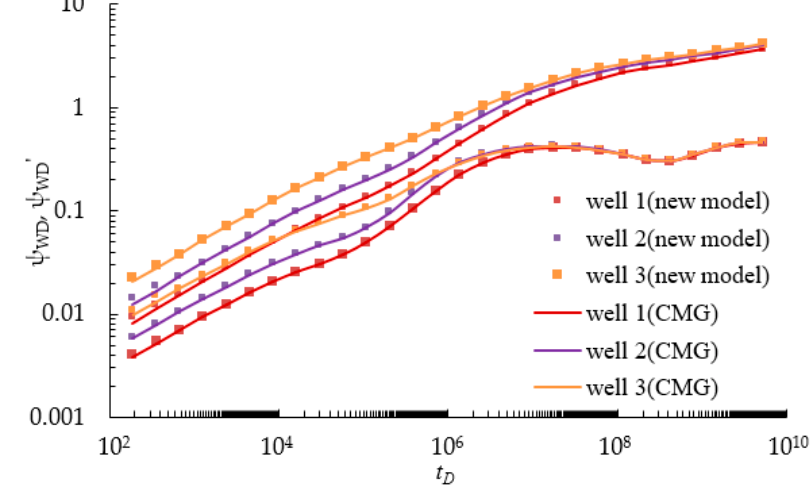
Figure 9. Top view of the numerical model of Case II in the CMG-GEM module.